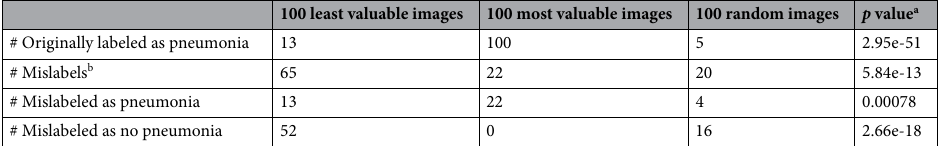
training data were identified as valuable. We note that after removing more than 20% of the training data, the precision and recall scores for TMC-Shapley values increased slightly (Fig. 2b–c), which might be because the percentage of positive cases increased after 20% of the training data were removed (Supplementary Figure S2a). Conversely, we removed data points from the least valuable to the most valuable as shown in Fig. 2d–f.